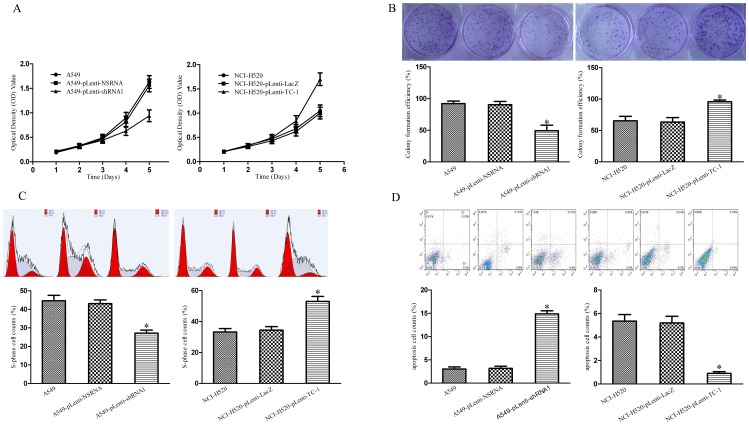
TC-1 promotes NSCLC cell proliferation, cell cycle transition, and apoptosis resistance in vitro.(A) MTT assay. The optical density value was detected at a series of time points to evaluate cell proliferation. (B) Plate colony formation assay. The colonies were stained with crystal violet staining solution and counted, and the clone formation rate was then calculated. (C) Cell cycle assay. The percentage of cells in the S phase was measured using a flow cytometer, and the data were analyzed using the ModFit LT software. (D) Cell apoptosis assay. The cells were incubated in the dark in a solution containing PE-A and PerCP-Cy5.5. The percentage of apoptotic cells (lower right quadrant) was analyzed using a FACS equipped with a doublet discriminating module, and the data were analyzed using the CellQuest software. The columns represent the average colony formation rate (B), S-phase cell rate (C), and apoptosis cell rate (D) from at least three independent experiments. The bars show the SE. *indicates statistically significant changes (P<0.05) among three groups.